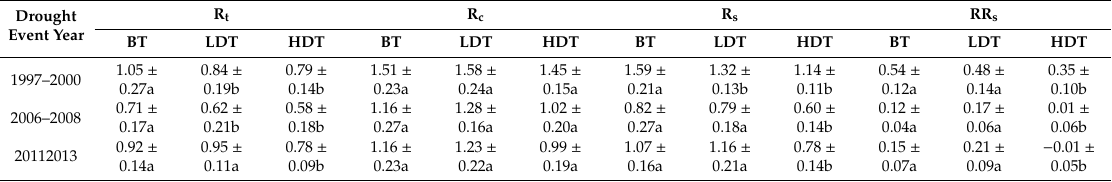
Table 2. Resistance (R t ), recovery (R c ), resilience (R s ), and relative resilience (RR s ) among the